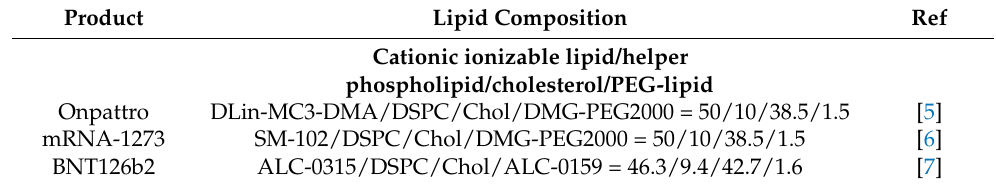
Table 1. Lipid composition of FDA-approved